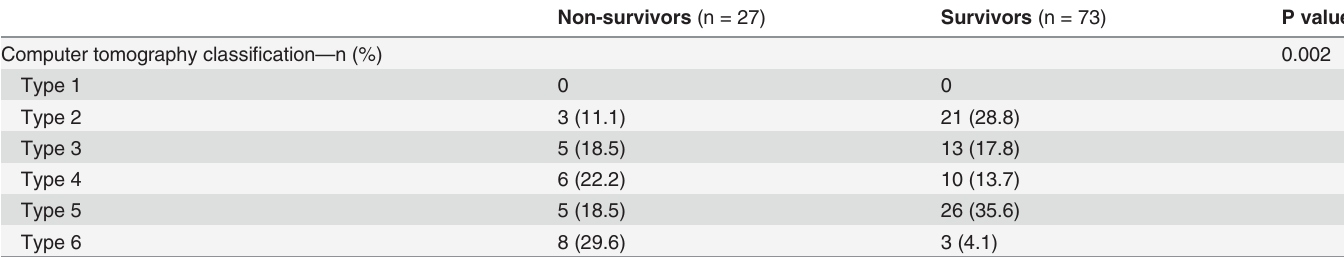
Table 1. Comparison of computer tomography findings between non-surviving and surviving patients with traumatic brain injury.